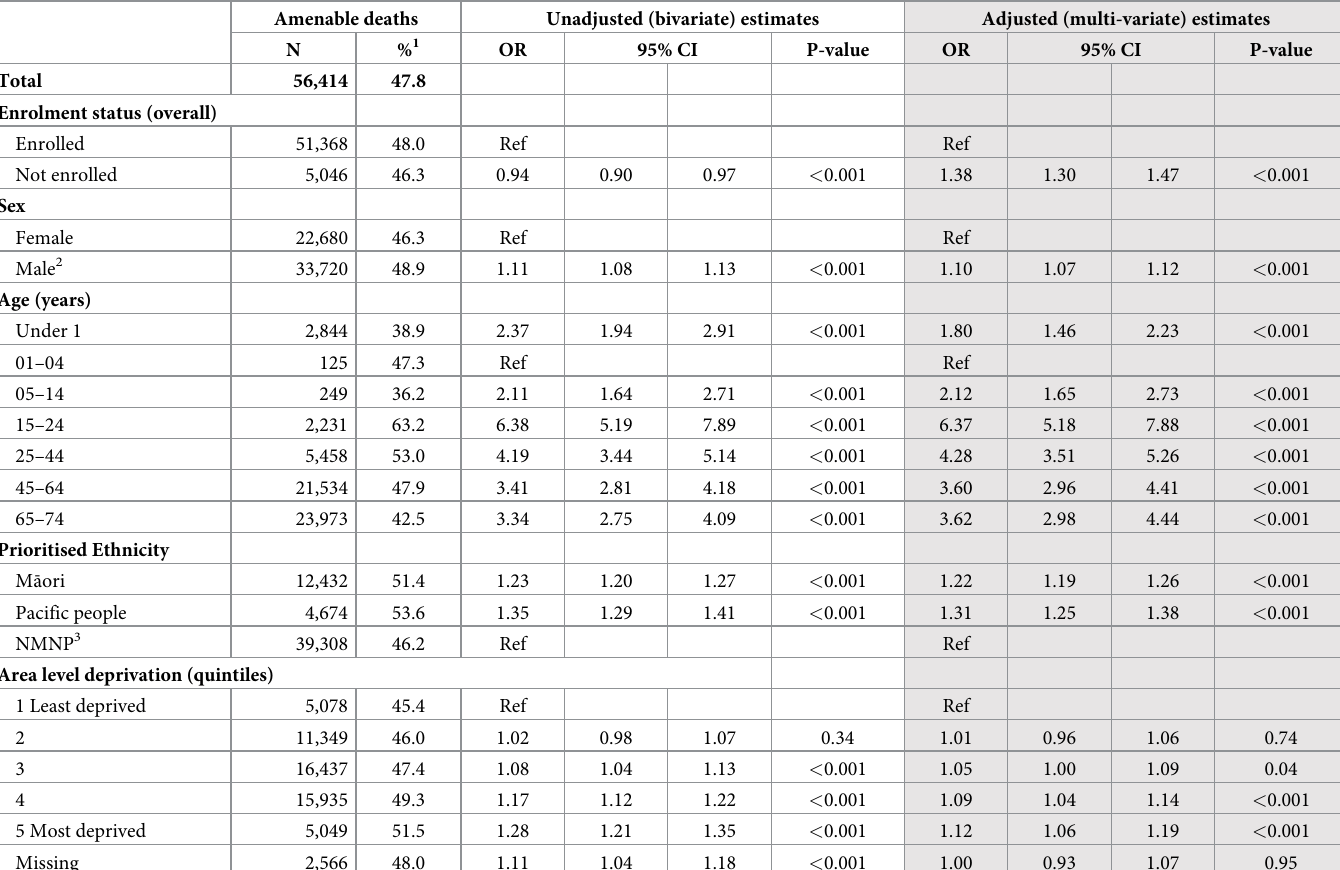
Table 3. Socio-demographic characteristics of amenable mortality cases and ORs of amenable deaths versus non-amenable deaths.